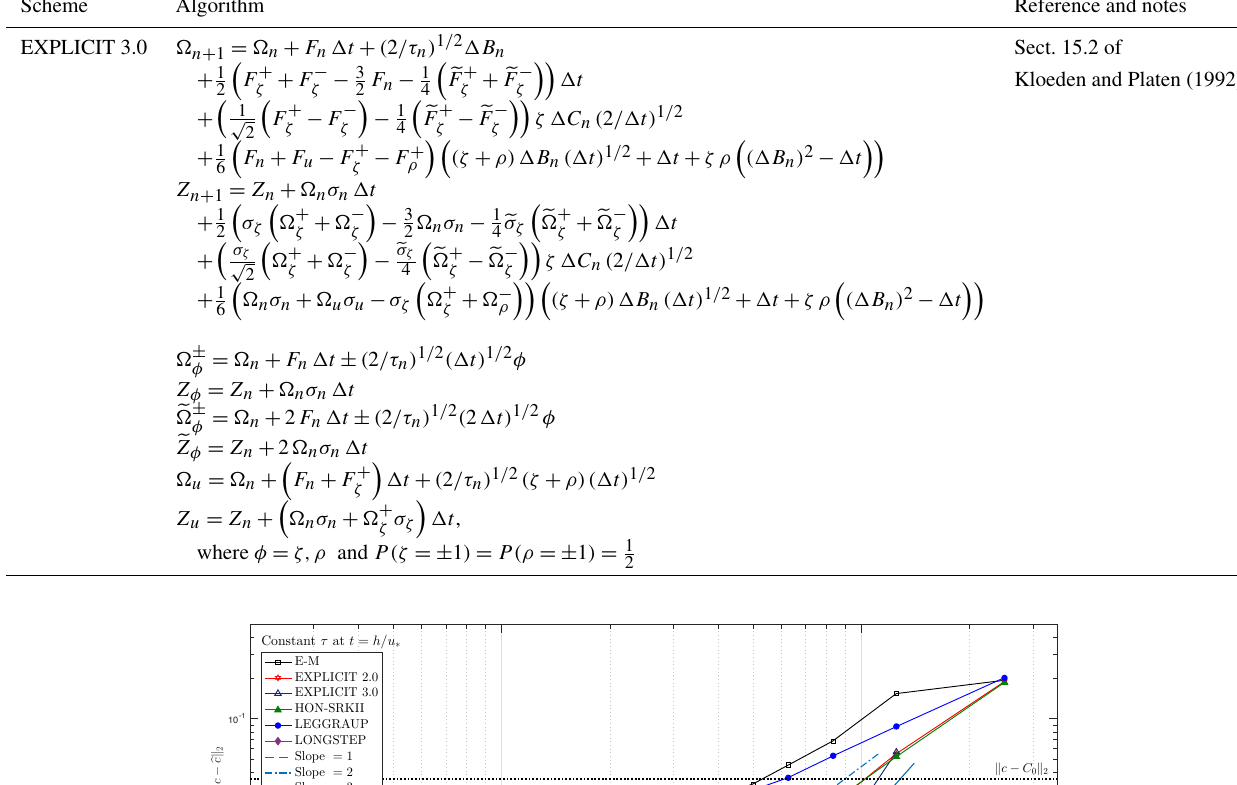
Table 3. EXPLICIT 3.0 scheme tested in Sect. 4, with τ n = τ(Z n ) , σ i = σ w (Z i ), and e σ φ = σ w ( e Z φ ) , where i = n,u,φ . The drift function is denoted by F i = − (cid:127) i /τ(Z i ) + σ (cid:48) w (Z i ) or e F φ = − e (cid:127) i /τ( e Z φ ) + σ (cid:48) w ( e Z φ ) . Here (cid:49)t is the time step and we use two correlated Gaussian random variables (cid:49)B n ∼ N ( 0 ,(cid:49)t) and (cid:49)C n ∼ N ( 0 ,((cid:49)t) 3 / 3 ) , with E((cid:49)B n (cid:49)C n ) = ((cid:49)t) 2 / 2. Scheme